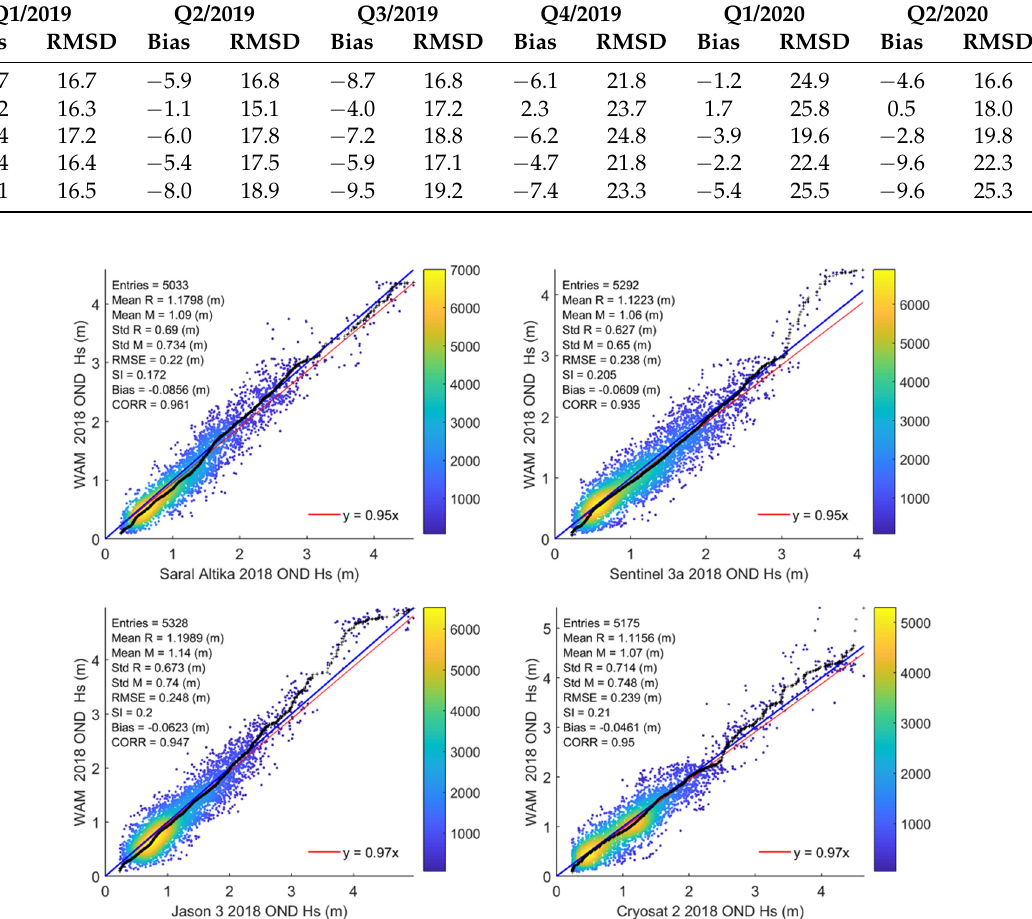
Figure 14. Scatter plots as in Figure 10, but for Q4 2018 and four different satellites.